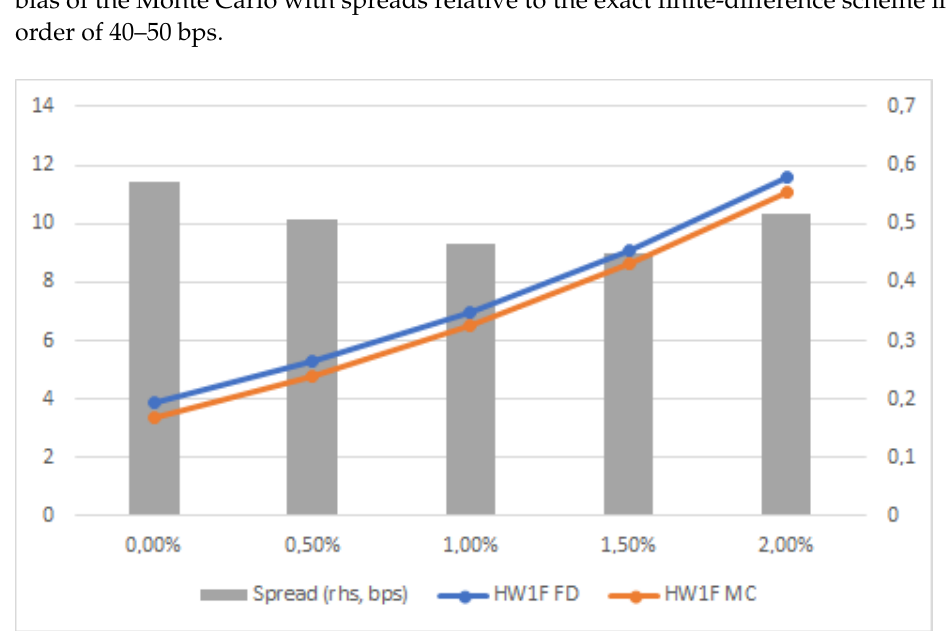
Figure 4. Comparison of “20-non-call-10” Bermudan swaption prices calculated with a one-factor Hull–White model using a finite difference scheme and Least Square Monte Carlo (in percent; USD market data as of September 2020). Note: for reference, the LSMC uses 25,000 presimulation paths to fit the coefficients and then another 25,000 with antithetic variates (a total of 50,000 paths) to estimate continuation values based on the previously determined decision rule; we used twelve time steps per year and standard Euler discretization; the Crank–Nicolson finite difference gird has a resolution of 20 time steps per year and 400 space